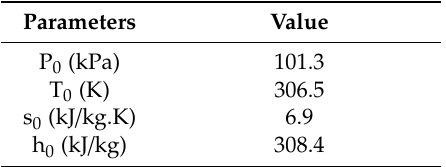
Table 6. Design parameters for exergy analysis of sea level